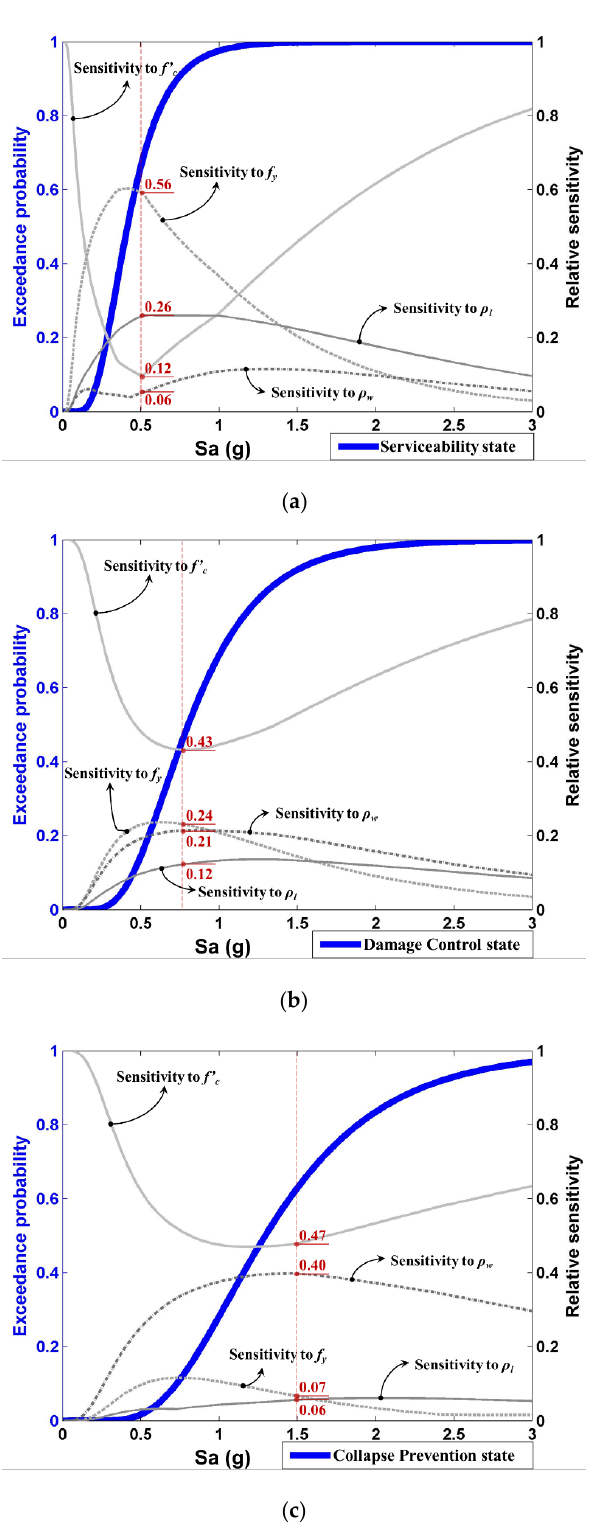
Figure 8. Relative sensitivity of uncertain variables on vulnerability curves: ( a ) serviceability; ( b ) damage control; ( c ) collapse prevention.